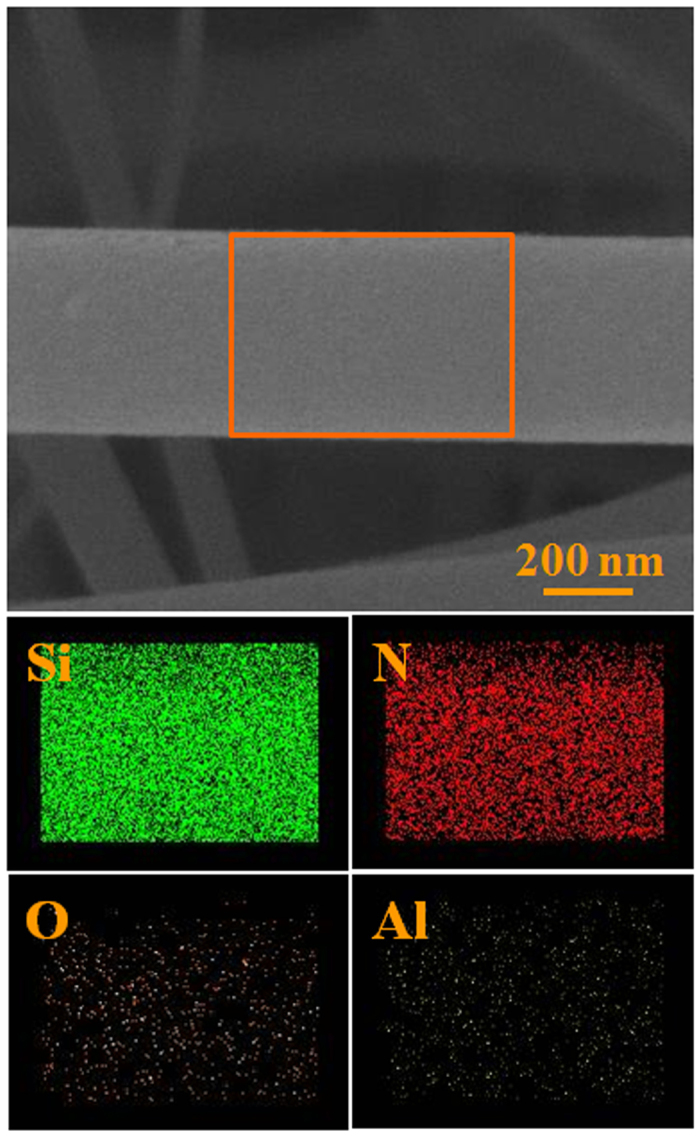
Elemental area scanning of a single Si3N4 NW.